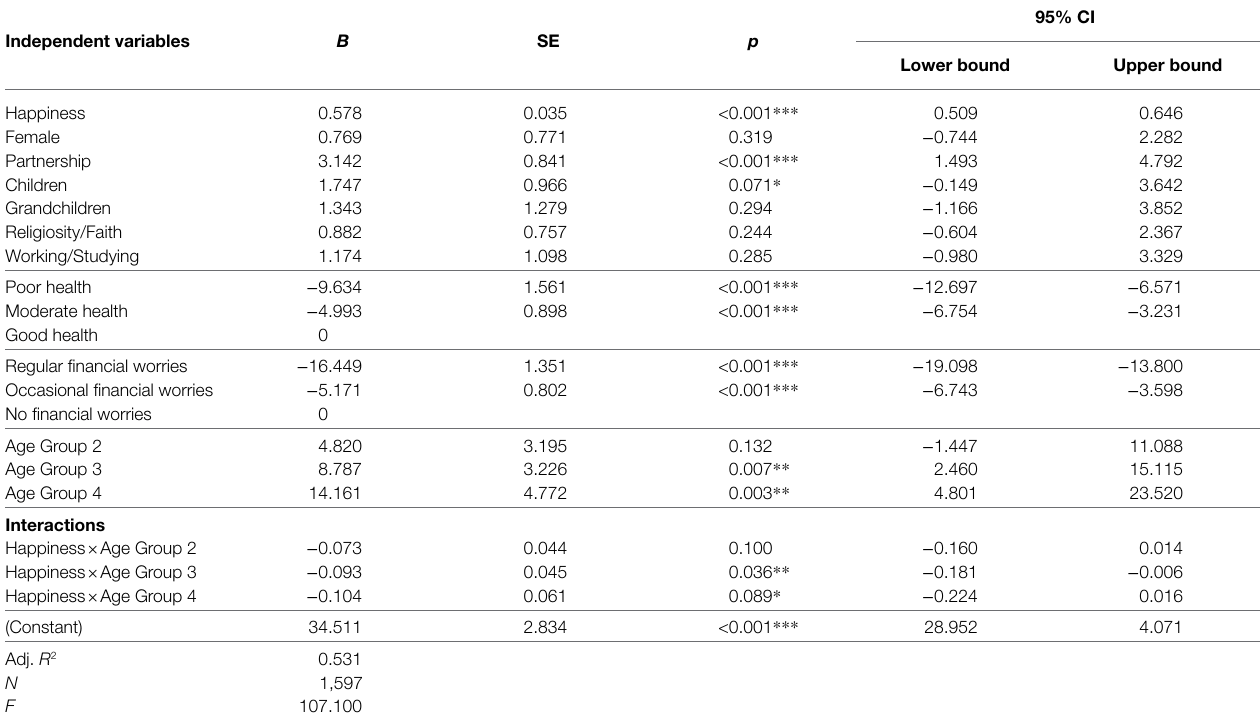
Independent variables